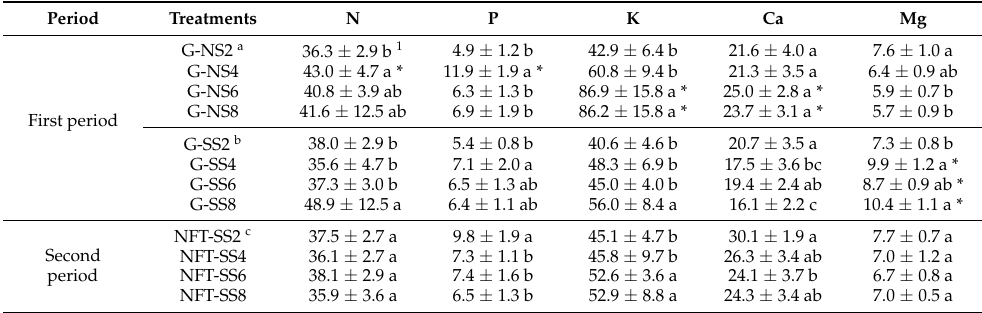
Table 5. Mean values ( ± SE) of leaf nutrient concentration expressed in mg g − 1 of dry leaf matter performed during the first and the second experimental